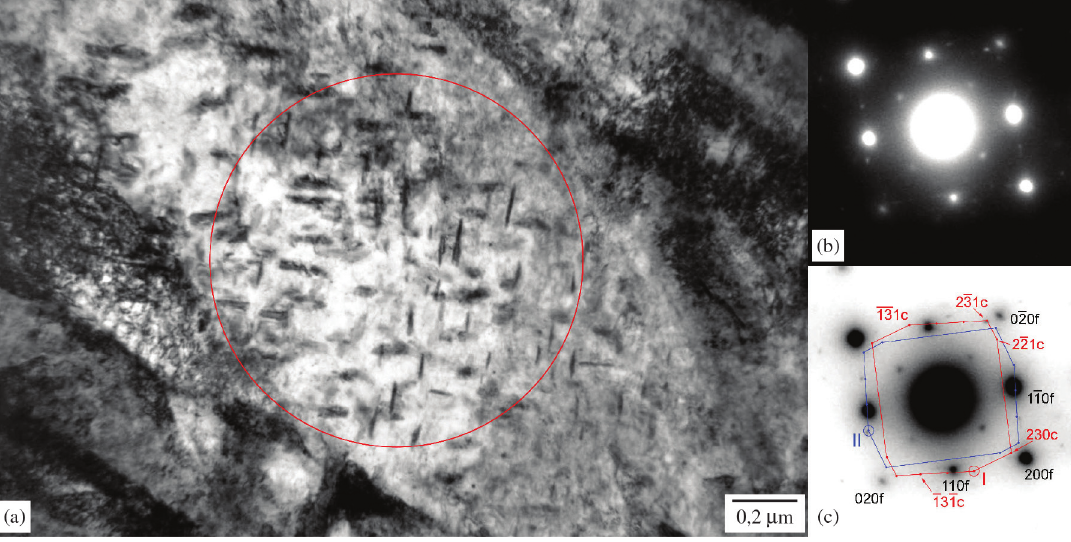
Figure 2. TEM BF micrograph showing formation of two orthogonal variants of fine cementite rods inside a martensite lath in (a). Electron diffraction pattern of the encircled area presenting zone axis close to [001]f in (b) and its key diagram in